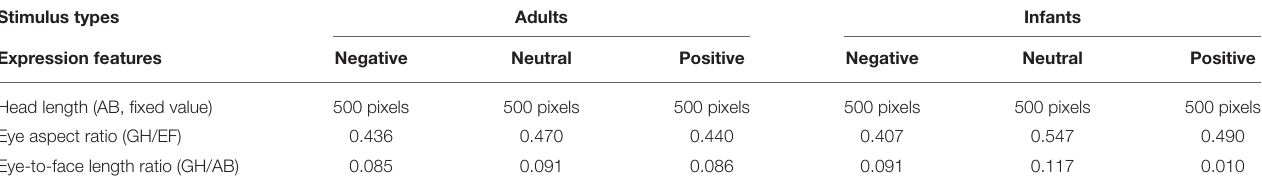
TABLE 2 | Average calculated results.